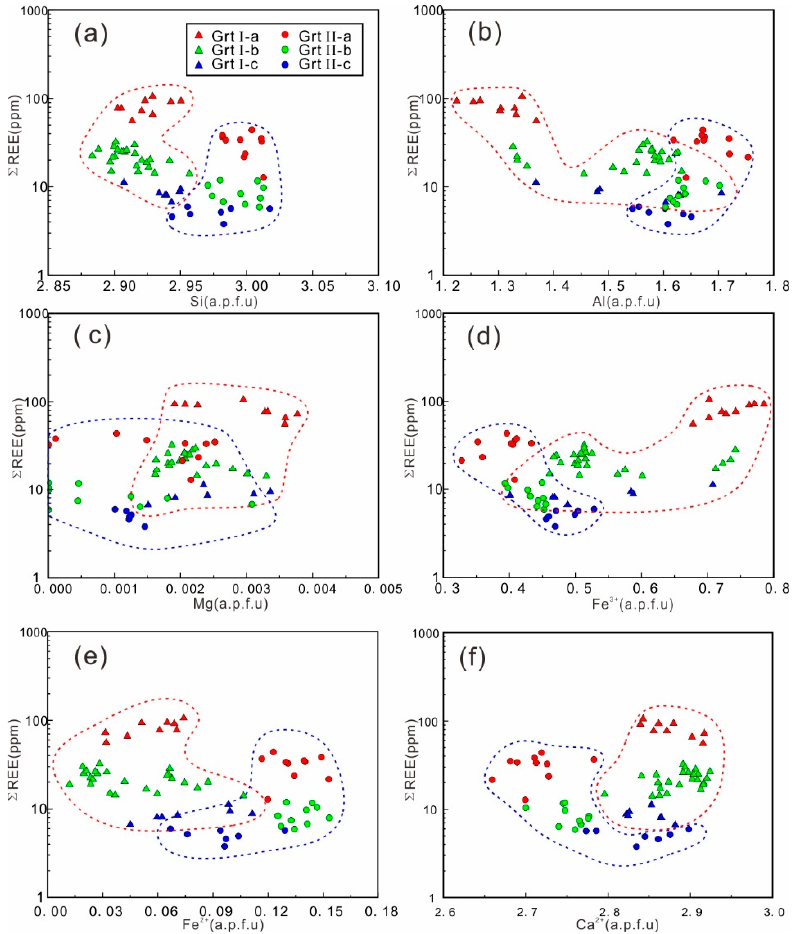
Figure 12. Binary plots of ( a ) Si (a.p.f.u) vs. ∑ REE; ( b ) Al (a.p.f.u) vs. ∑ REE; ( c ) Mg (a.p.f.u) vs. ∑ REE; ( d ) Fe 3+ (a.p.f.u) vs. ∑ REE; ( e ) Fe 2+ (a.p.f.u) vs. ∑ REE; ( f ) Ca 2+ (a.p.f.u) vs. ∑ REE.